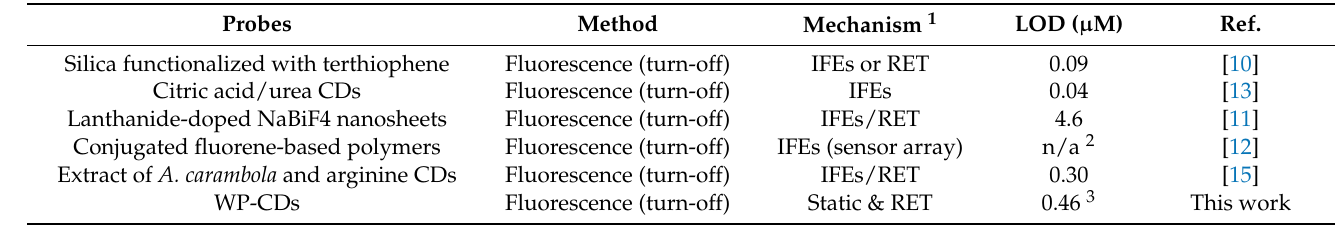
Table 1. Comparison of recent methods of MO detection based on nanostructured materials and